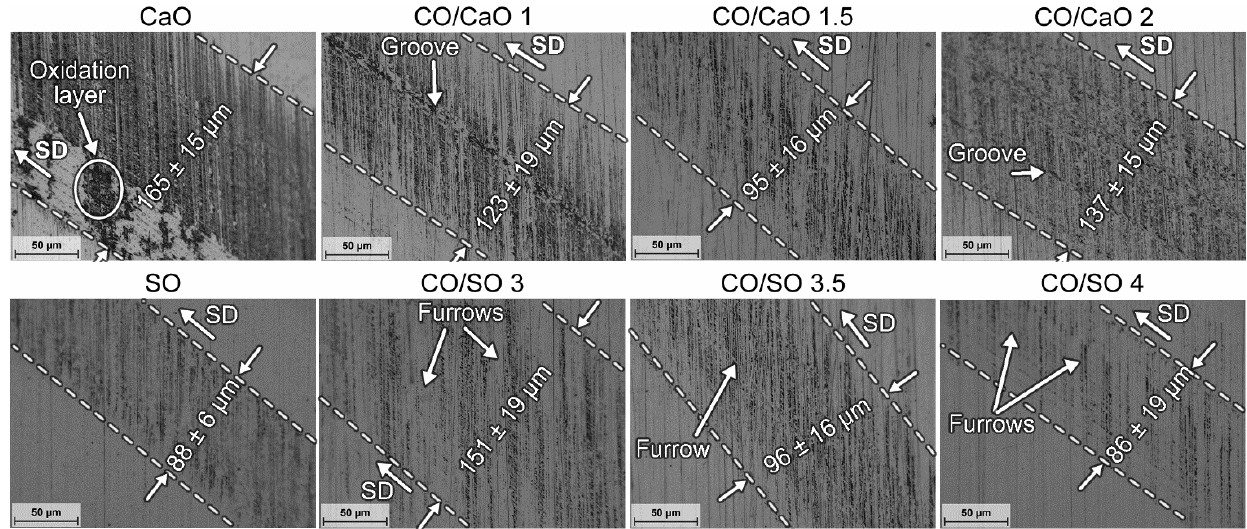
Figure 6. Worn surface analysis of AISI 8620 steel lubricated with canola oil, sesame oil, and their binary oil mixtures. Optical micrographs were taken at 500X. SD represents the direction of sliding.